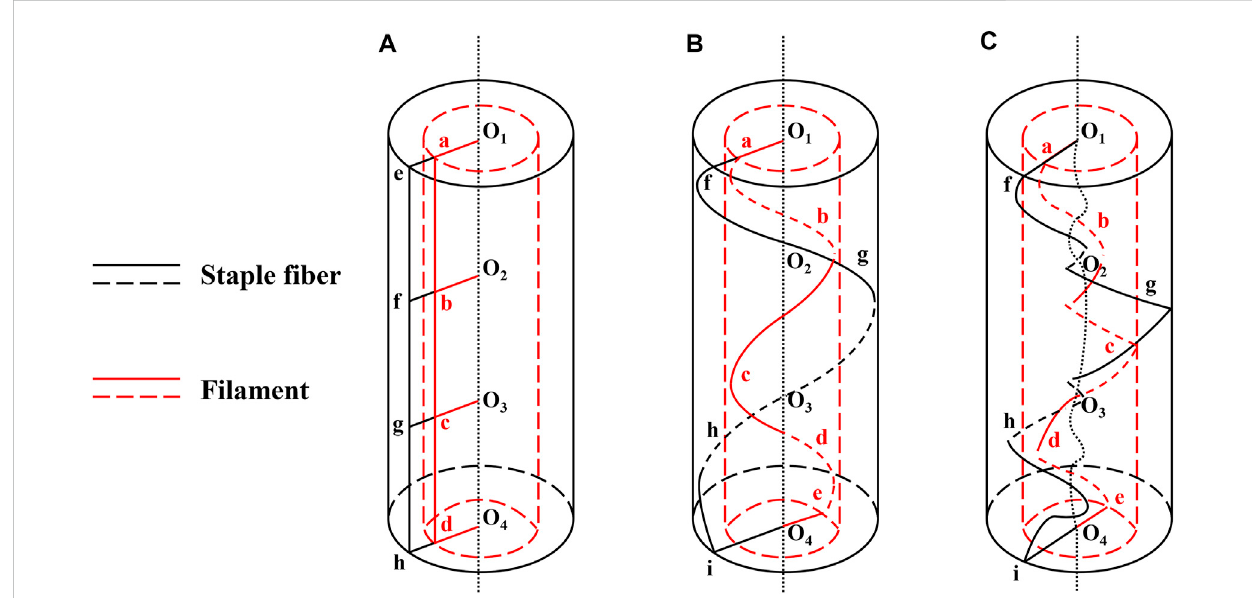
FIGURE 1 Geometrical illustration of fi ber motion trace: (A) staple fi ber and fi lament strands; (B) composite yarn twisted by the same direction and (C) composite yarn twisted by alternate direction.